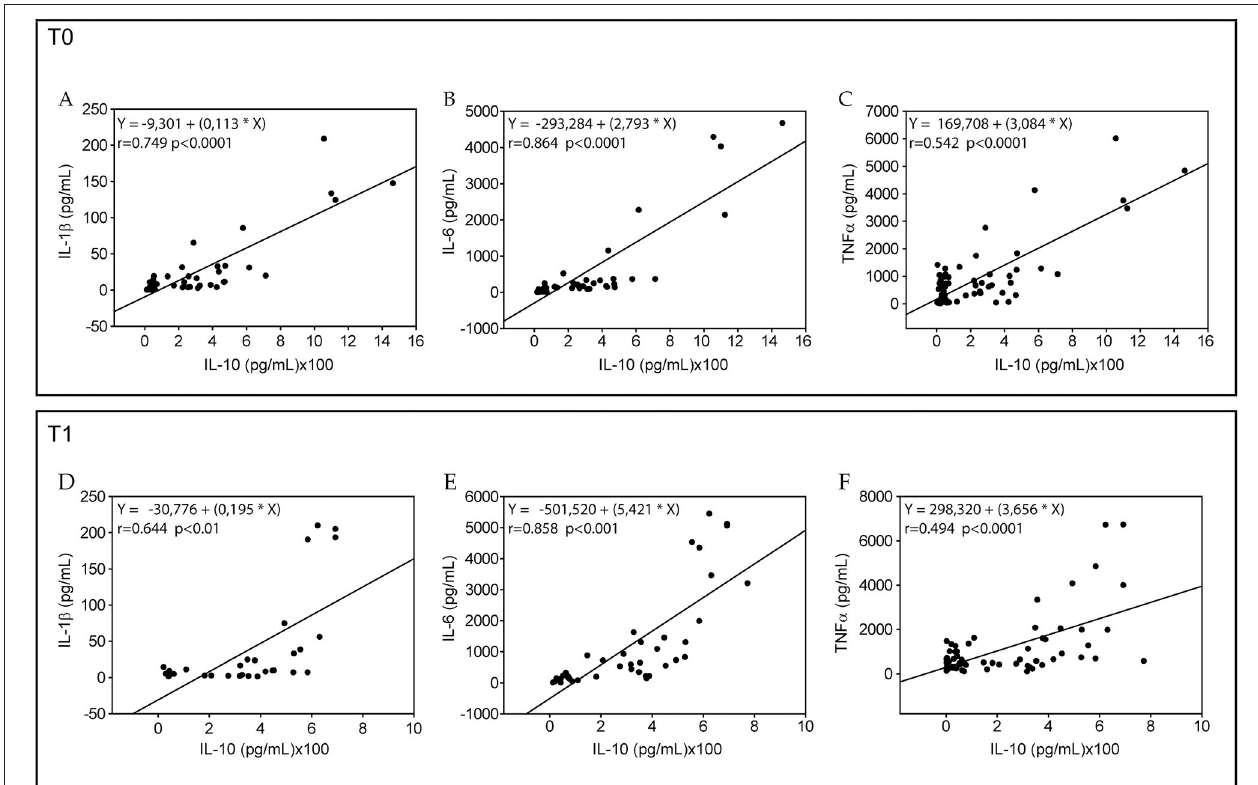
FIGURE 2 | Correlations between interleukin-10 and interleukin-1 β , interleukin-6, or tumor necrosis factor (TNF)- α in all sample at baseline (T0) and after 6 months (T1). Association of interleukin (IL)-10 with IL-1 β (A,D) , IL-6 (B,E) , and TNF- α (C,F) in all samples at baseline (T0) and after 6 months (T1) were analyzed by Spearman’s correlation test. For each linear regression graph, the linear equation (Y), the correlation coefficient ( r ), and the statistical significance ( p ) are reported.